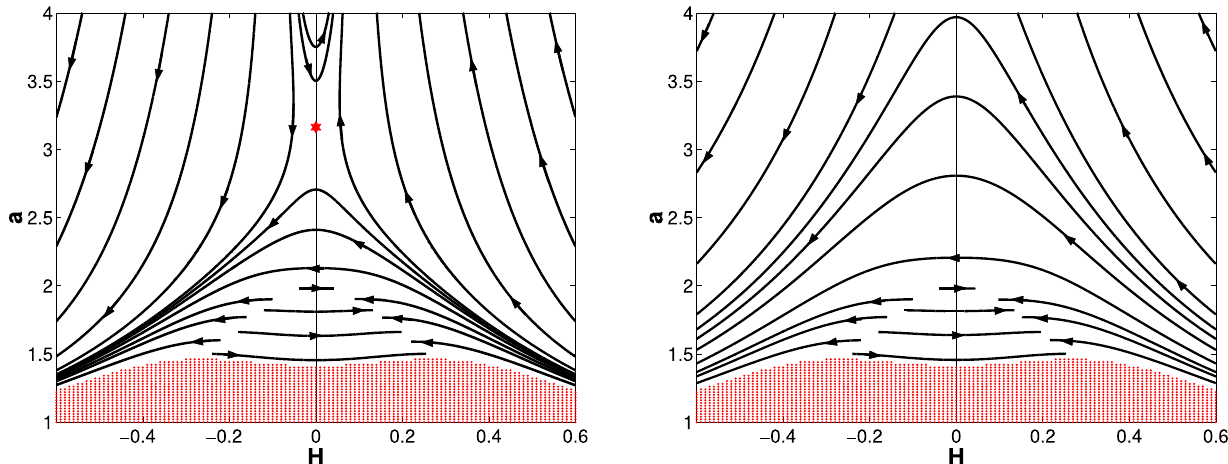
Fig. 2 The phase portraits are plotted for N = 2, f 0 = − 1 dotted regions correspond to ρ < 0 in the constraint equation (11)